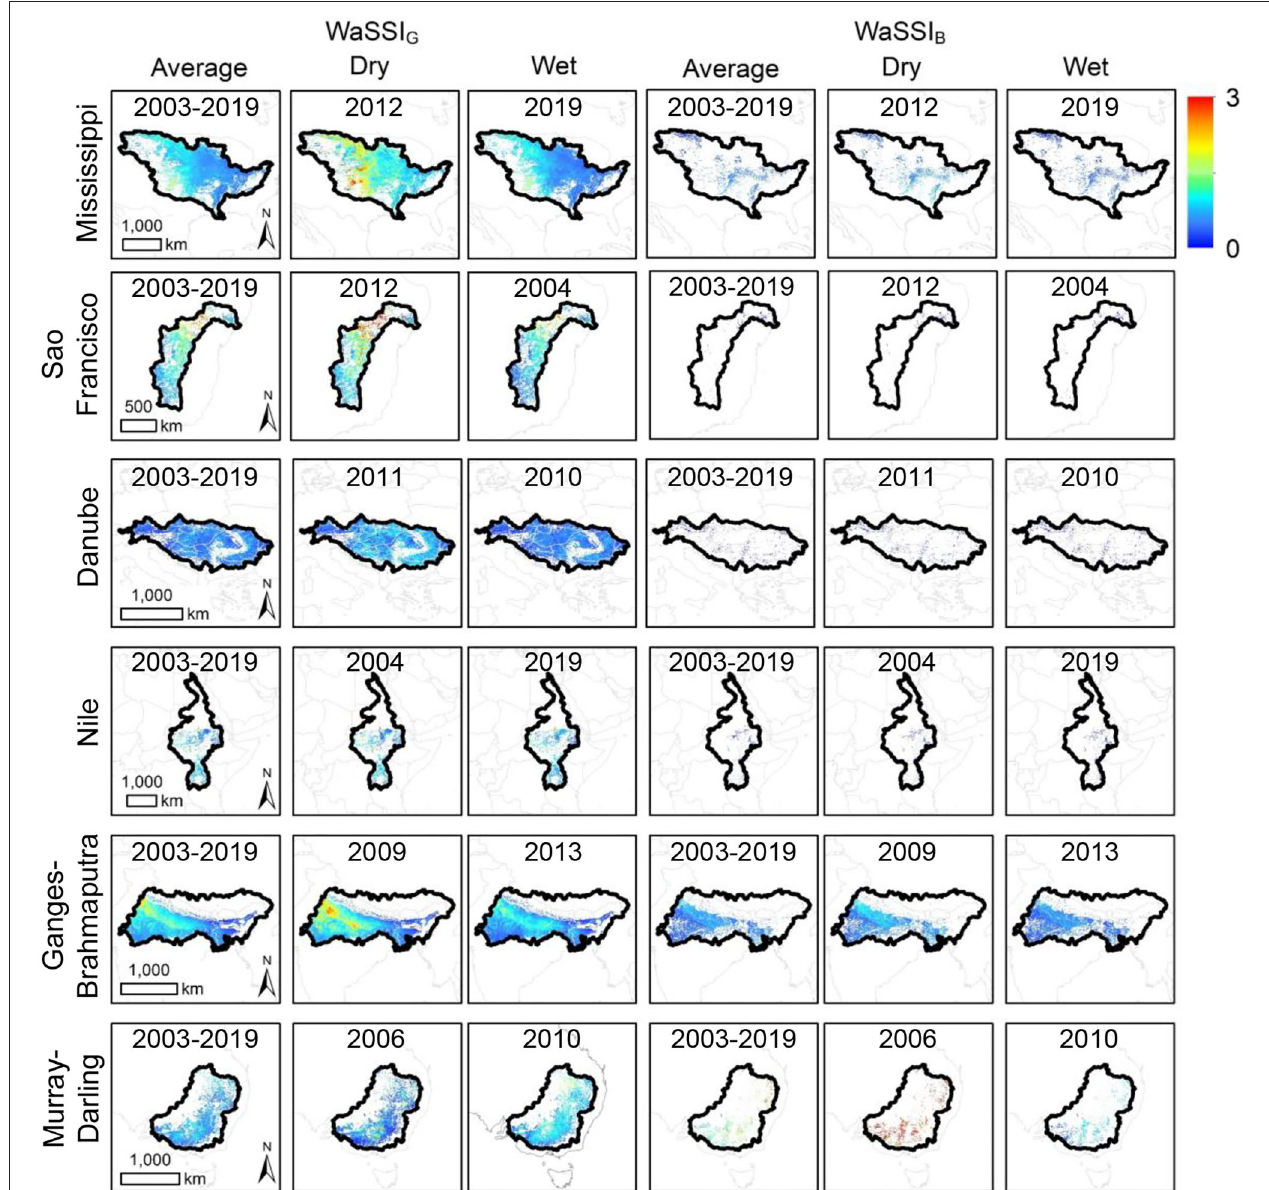
FIGURE 4 | Spatial variation of green (WaSSI G ) and blue (WaSSI B ) water supply stress indices during dry- and wet-years across study basins.